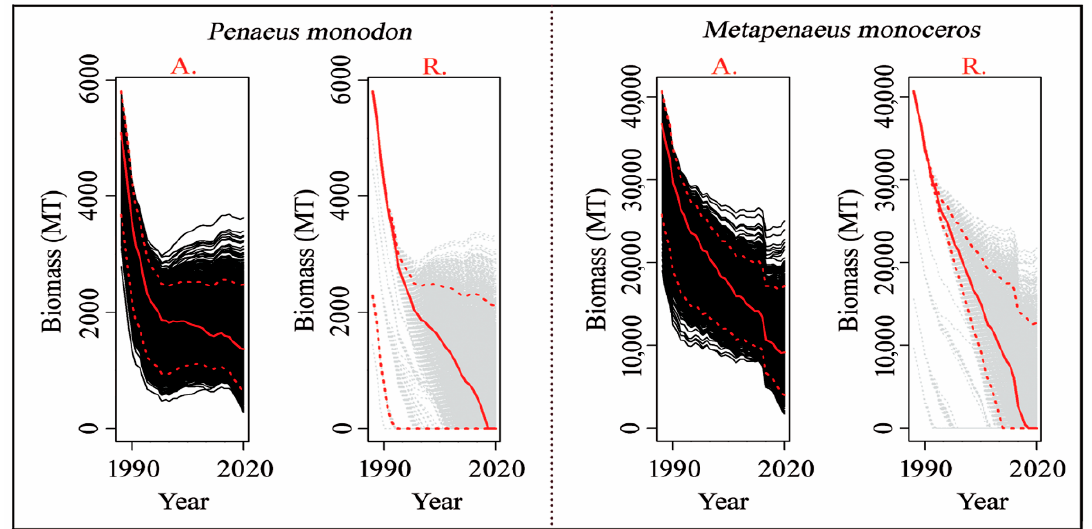
Figure 5. Historical catches of Penaeus monodon and Metapenaeus monoceros with MSY estimates.